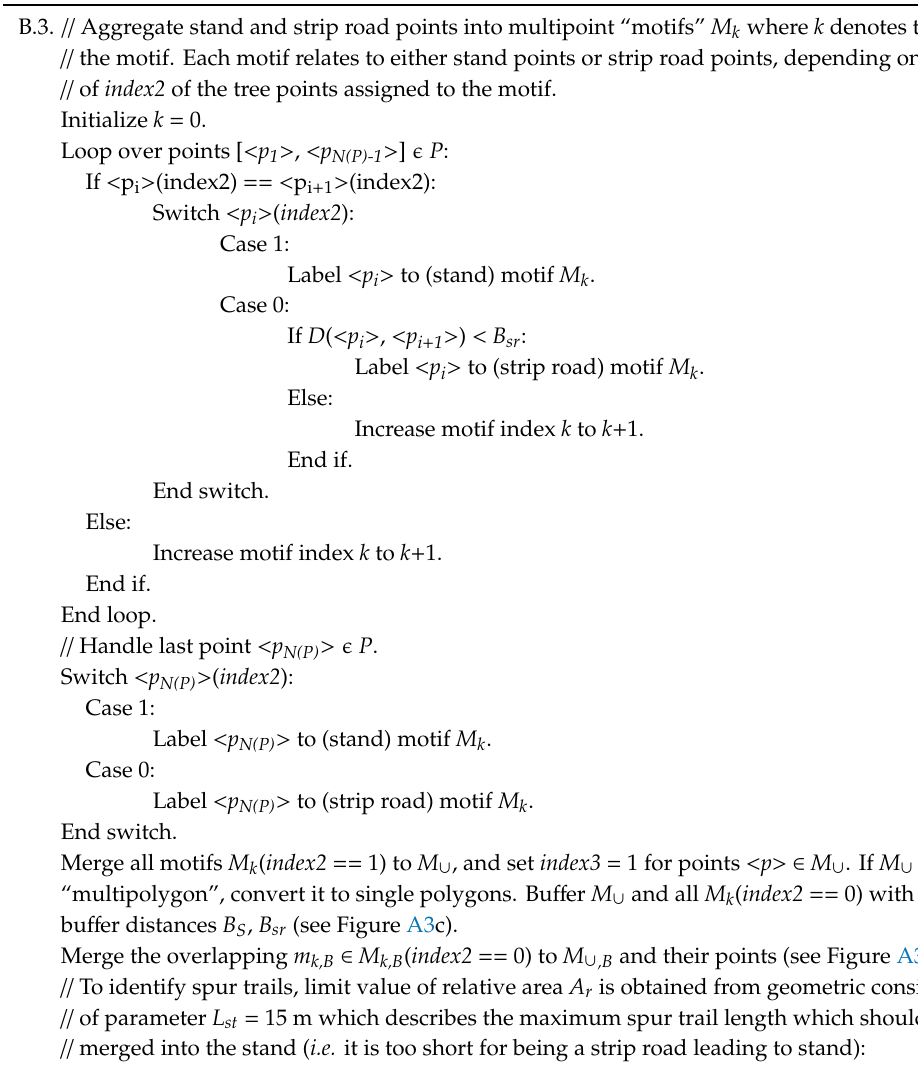
B.3. // Aggregate stand and strip road points into multipoint “motifs” M k where k denotes the index of // the motif. Each motif relates to either stand points or strip road points, depending on the value // of index2 of the tree points assigned to the